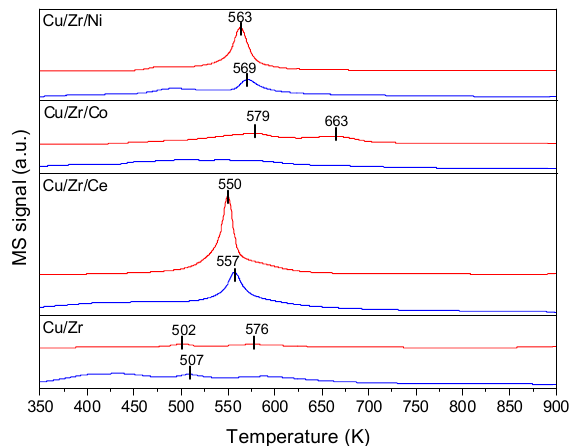
Figure 9. TPO profiles for spent catalysts: CO 2 —red line and H 2 O—blue line (signal multiplied by factor of 8).